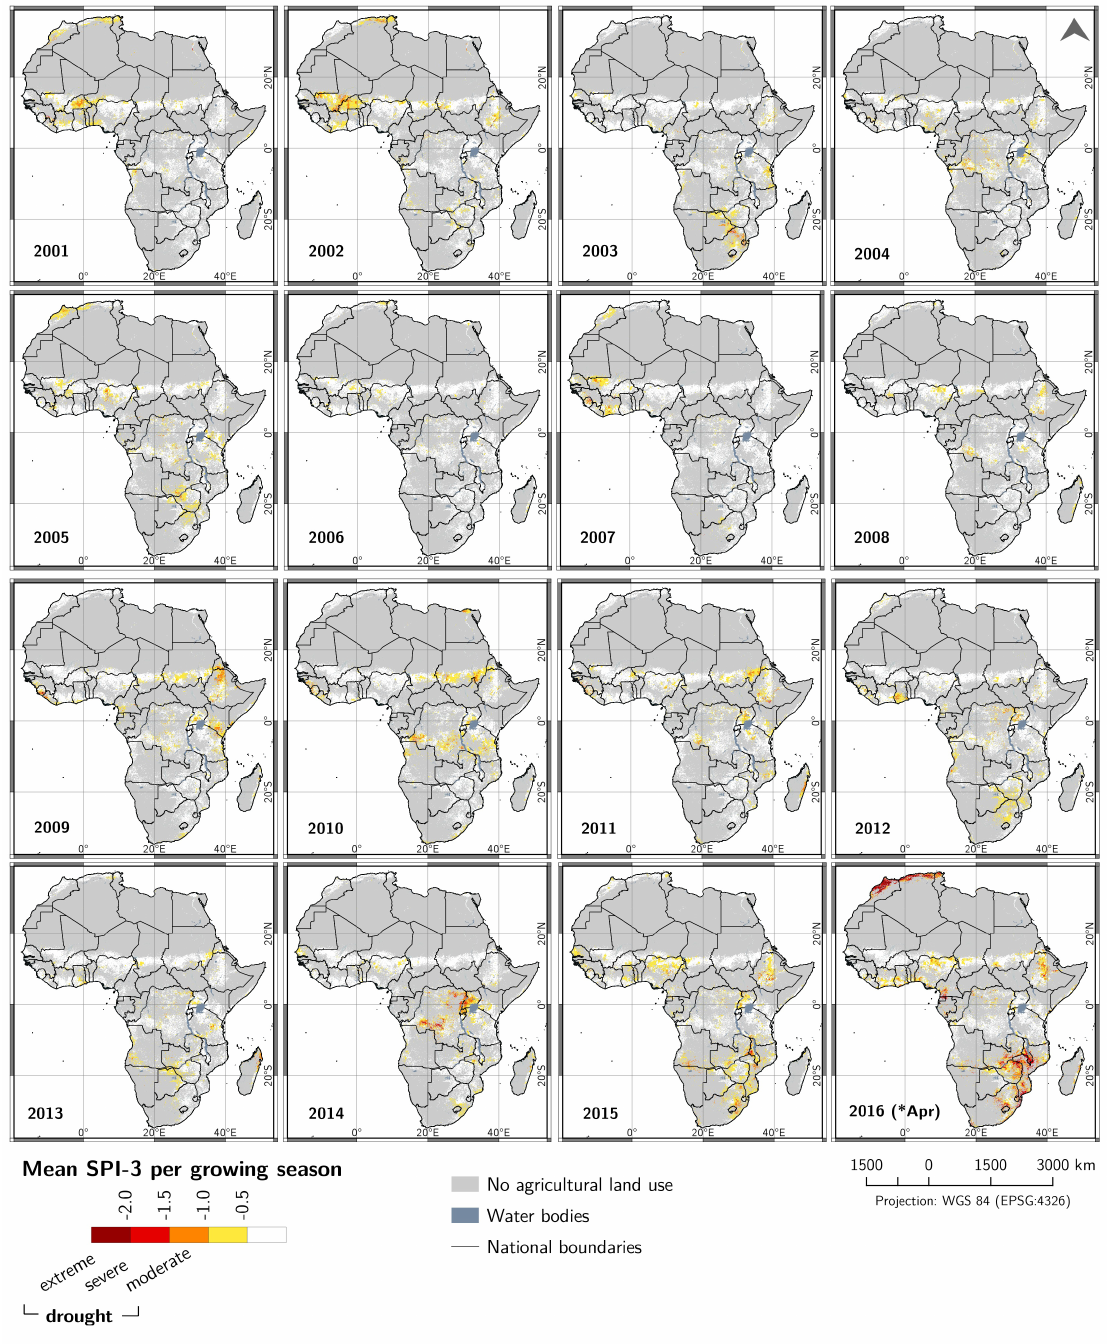
Figure 4. Intensity of drought: Mean SPI-3 per growing season from 2001 to 2016 (seasonal years). The lower the SPI-3, the more intense is the